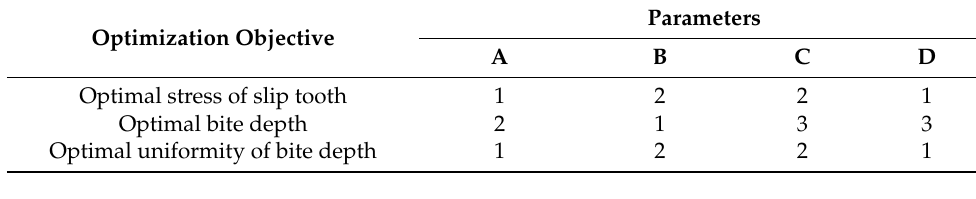
Table 8. Optimal combination of objective functions.